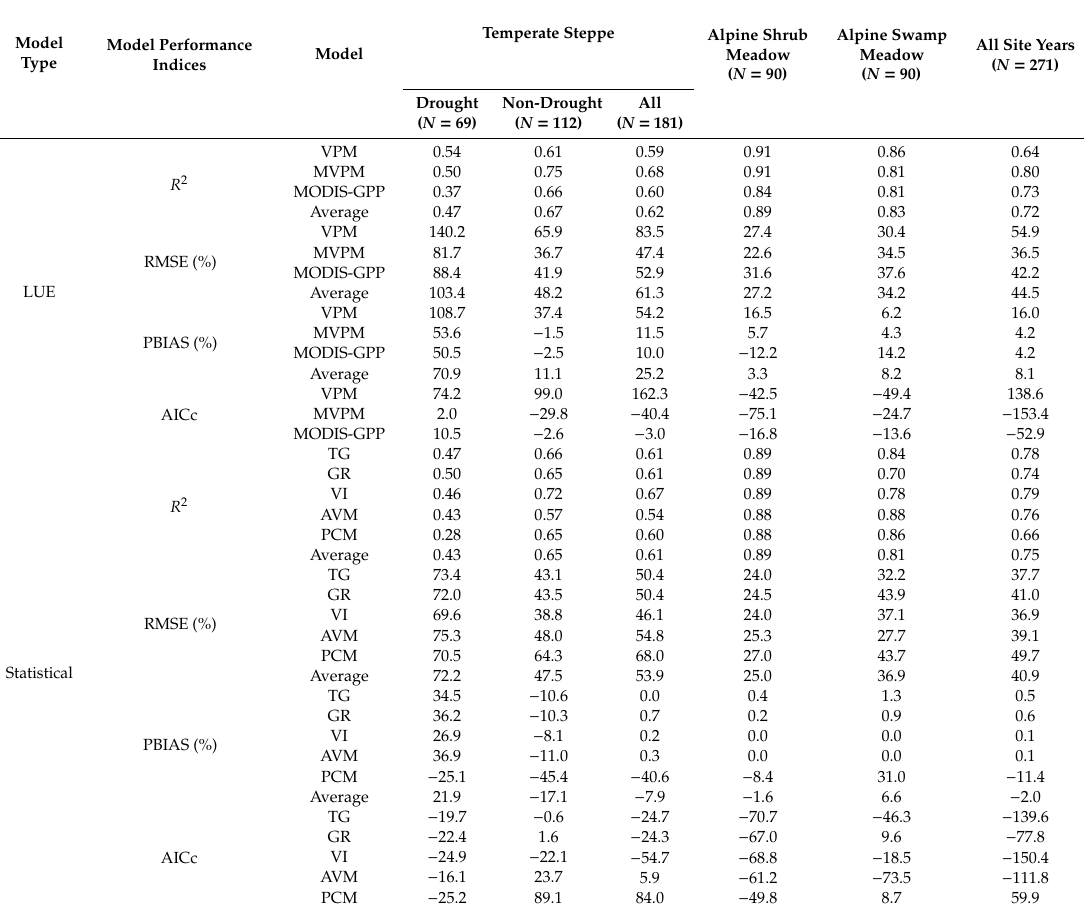
Table 3. Performances of the VPM, MVPM, MODIS-GPP, TG, GR, VI, AVM, and PCM in estimating GPP over the temperate steppe and alpine meadow as reflected by R 2 , RMSE (%), PBIAS (%) and AICc validation. N represents the number of data